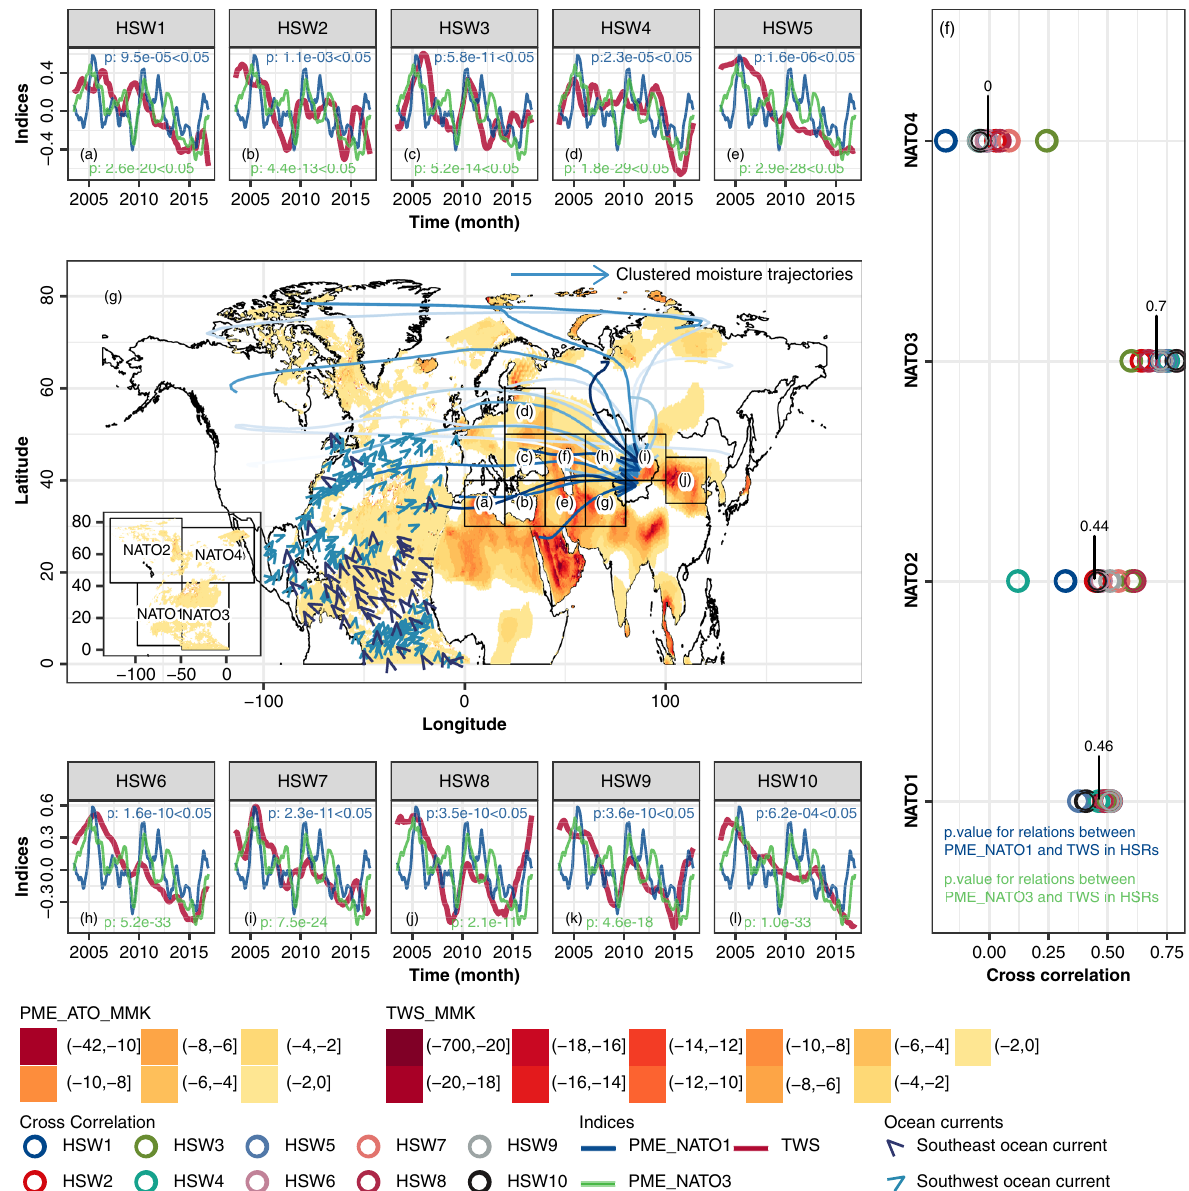
Fig. 2 Spatiotemporal evolutions in PME over NATO and TWS across Eurasia. Temporal covariations among the normalized trend items of the regional sums of terrestrial water storages (TWSs) in sub-regions 1 – 10 (HSRs 1 – 10) across mid-latitude (N30° – N60°) Eurasia and the normalized trend items of the regional sums precipitation-minus-evapotranspiration (PMEs) in NATO1 and NATO3 ( a – e and h – l , respectively). Spatial patterns of the modi fi ed Mann- Kendall (MMK) trends of PMEs in the NATO and TWSs in North Africa, Europe and Asia ( g ). Cross Pearson ’ s correlation between PMEs in northern NATOs and TWSs in HSRs 1 – 10 ( f ). PME_NATO_MMK refer to the MMK trend in PMEs over NATO. TWS_MMK refers to the MMK trend in TWS across Eurasia and North Africa. The ocean currents in the plot were the long-term averaged ocean currents in NATO based on the OSCAR (Ocean Surface Current Analysis Real-time) dataset during 1993 – 2019. The moisture trajectories in subplot ( g ) were clustered using the k -means cluster method based on the locations of particles in the trajectories. into 19 sub-regions (10 (cid:1) ´ 10 (cid:1) ). Then we further de fi ned 10 sub- PME de fi cits over LNATO caused the TWS loss along HSR1-10 regions where TWSs were highly correlated with PME in NATO3 via water vapor transport by the northward ocean currents and (the cross-correlation > 0.50) as high-correlated sub-regions subsequent landward landfalling of PME de fi cits by the westerlies (HSR), and de fi ned other sub-regions as low-correlated sub- during 2003 – 2017 (Fig. 2g). In this case, we detected the average regions (LSR) (Supplementary Figs. 9 and 10). cross correlations of 0.46 and 0.7 between steadily decrease in Spatially, HSR1-10 formed a successive channel of water vapor PME over LNATO (NATO1 and NATO3) and decrease in TWS transport, transmitting the impact of PME variations over NATO along HSR1-10 (Fig. 2 and S9). On the contrary, the PME along MLE to TWS in Xinjiang (Supplementary Fig. 11). The variations over high-latitude NATO (NATO2 and NATO4) and NATURE COMMUNICATIONS| (2022) 13:1849